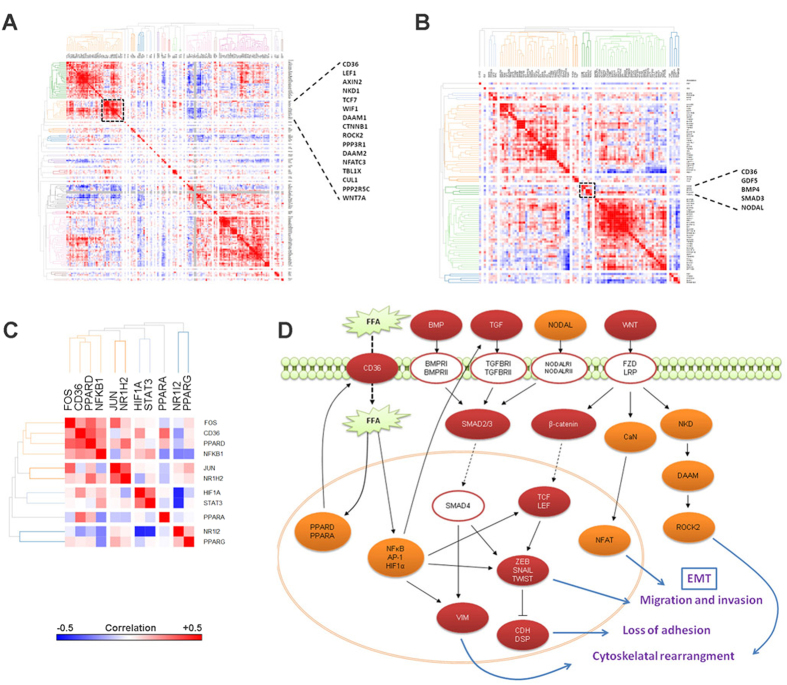
Correlation matrix heatmaps showing the association between mRNA expression z-scores (TCGA) of CD36 and (A) Wnt signaling pathway genes (KEGG) (B) TGF beta signaling pathway (KEGG) (C). PPARs and transcriptional mediators of inflammatory pathways known to be induced by free fatty acids. Genes are clustered with average linkage hierarchical clustering using 1-Pearson’s correlation as distance metric. Black boxes in (A,B) show the nearest neighbors of CD36 with strong positive correlation, with enlarged list showing the names of genes in that cluster. (D) Overview of the influence of elevated free fatty acid uptake on cell signaling pathways resulting in the induction of EMT program. Red ovals represent genes that were upregulated in vitro in PA treated HCC cells; orange ovals represent genes that show positive correlation with CD36 in the TCGA dataset; white ovals represent genes that did not show a significant correlation with CD36 in the TCGA dataset. Dashed black arrows show transport/translocation, solid black arrows and bar-headed lines indicate positive and negative regulation respectively. Blue arrows indicate consequence of activation of the proteins in context of the EMT program.